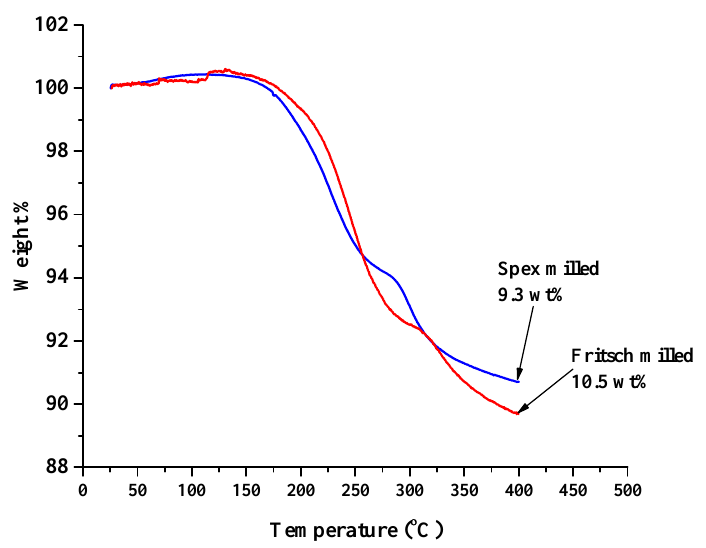
Figure 3. TGA curves for Fritsch (red) and Spex (blue) milled unmodified 1:1 LiNH mixture. The apparent slight increase in mass observed at the start of heating is attributed to the expansion of the argon carrier